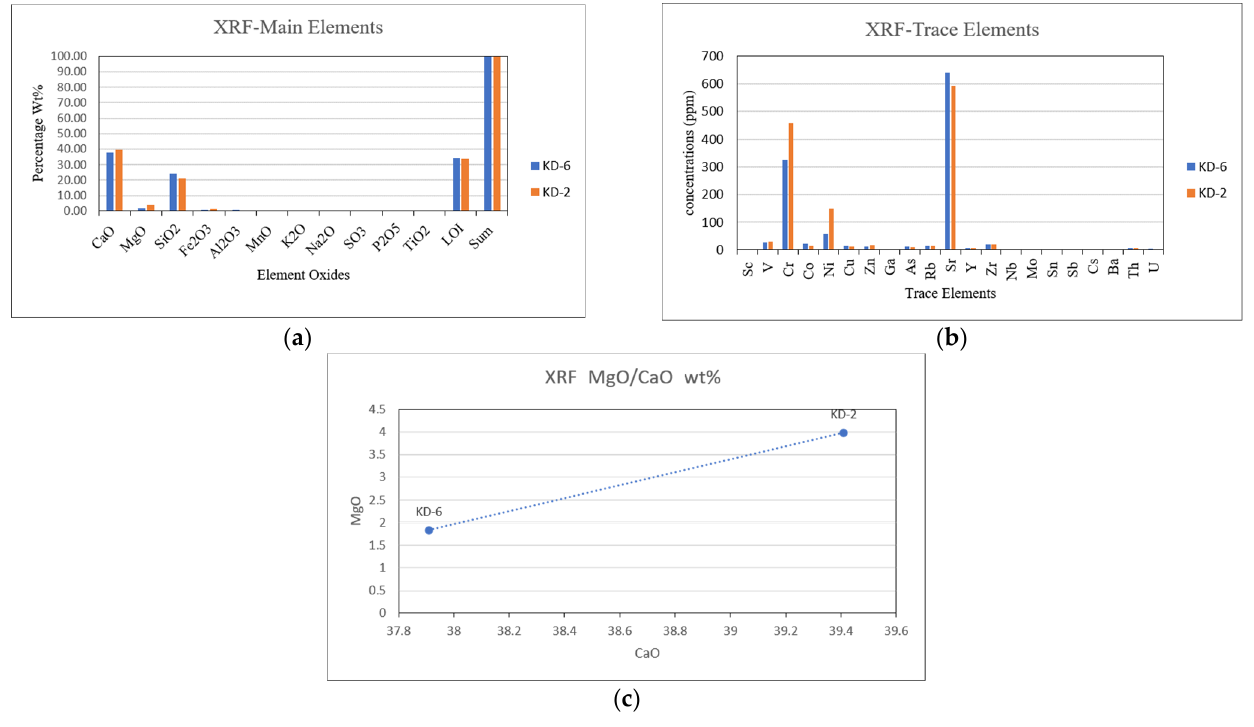
Figure 5. The abbreviations KD-2 and KD-6 stand for the XRF analysis of beachrock samples Kodi2 and Kodi6, respectively. ( a ) Bulk sample chemical analyses of major elements. All values are in wt. %. ( b ) Bulk sample chemical analyses of trace elements. All values are in ppm. ( c ) Comparison of MgO and CaO concentration values in wt. %.